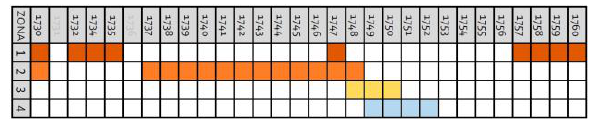
Figure 11. Bar diagram of the execution of four differentiated zones of the Land Front. Own elaboration. Right after finishing the three counterguards, the construction